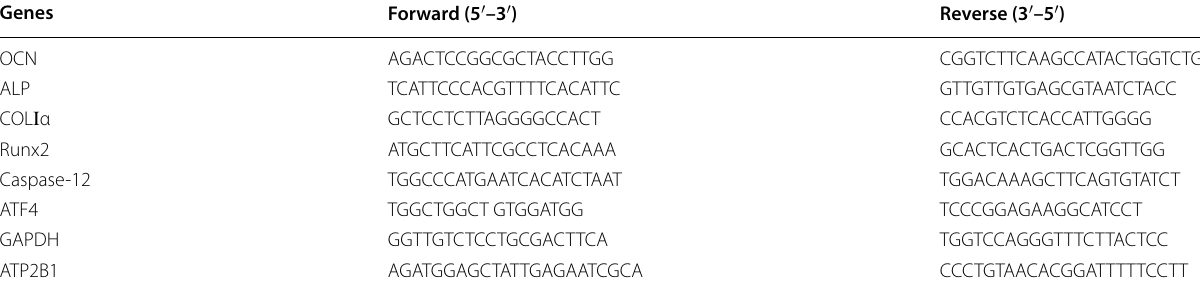
Table 1 Primers sequence for PCR